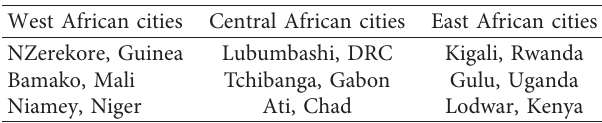
Table 3: Cities in West, Central, and East African regions. West African cities Central African